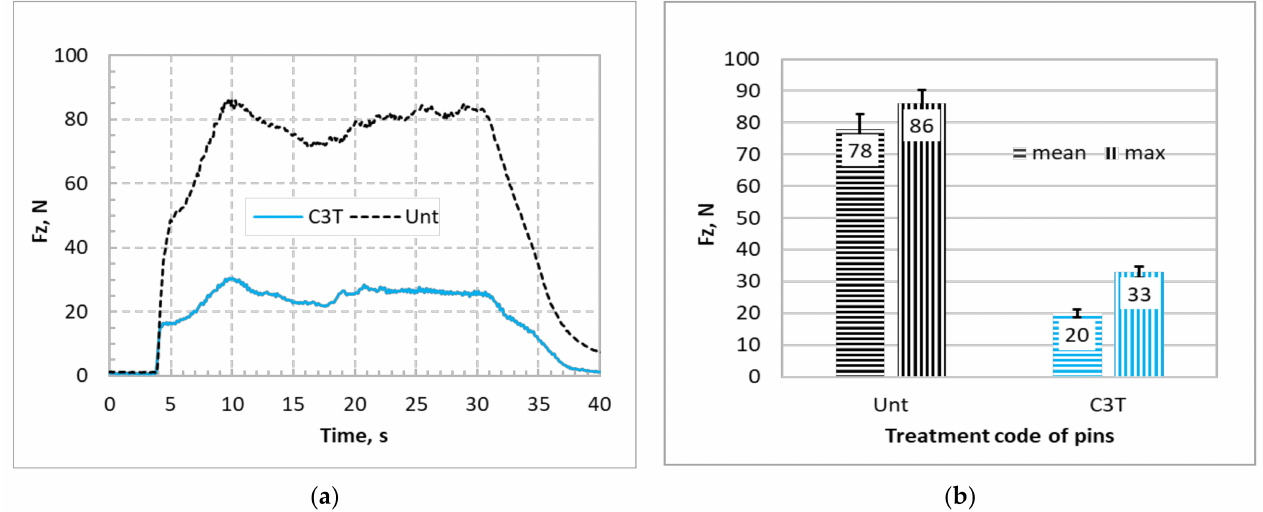
Figure 9. Comparisons of ( a ) recorded insertion forces against drilling time and ( b ) average and maximum insertion forces for untreated and C3T660-5PdAg treated self-drilling/self-tapping pins inserting into SAWBONES ® cortical bone plates.